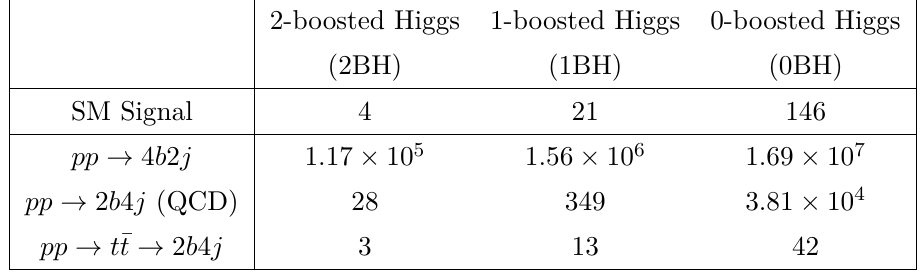
Table 3 . The numbers of events in the 2BH case, 1BH case and 0BH case at 14 TeV LHC are